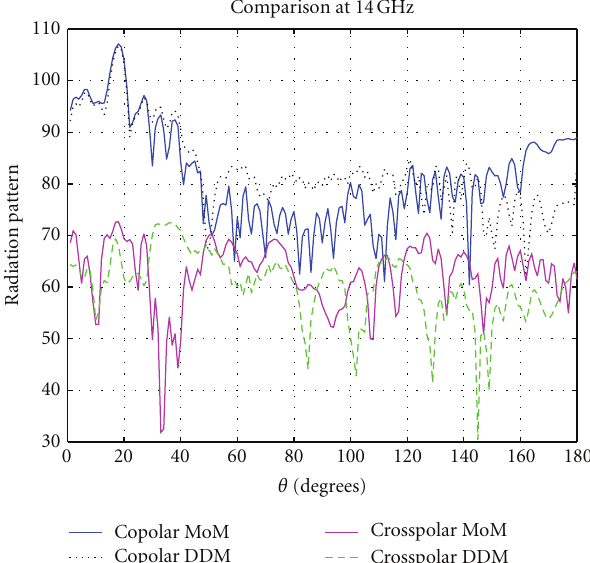
Figure 5: Comparison of radiation patterns applying the Moment Method and the domain decomposition approach at 14 GHz.